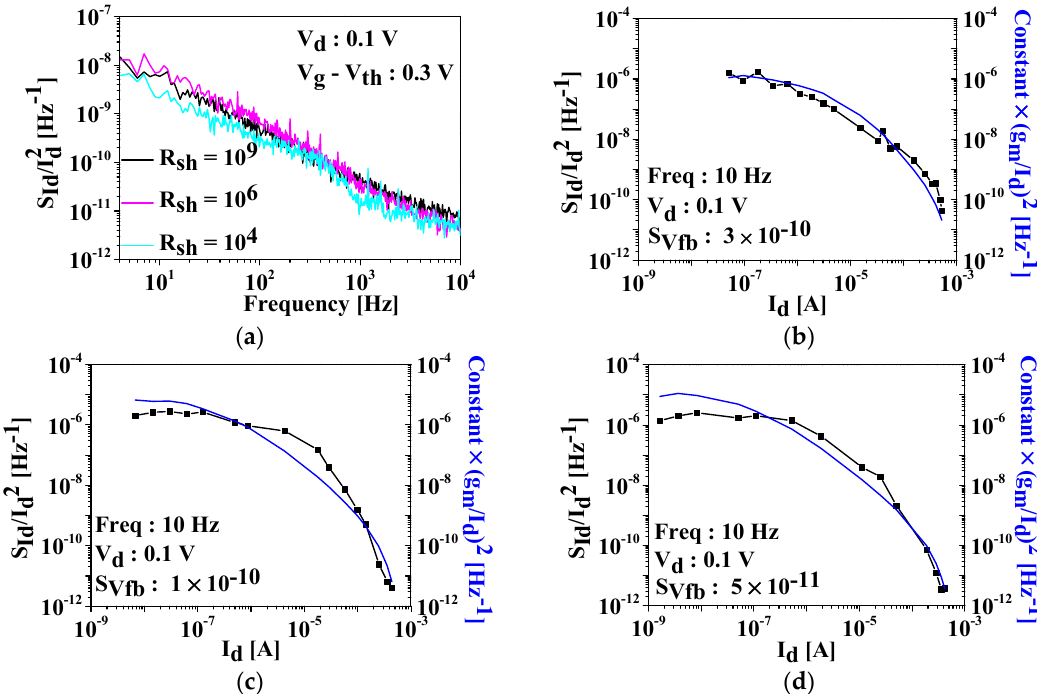
Figure 3. ( a ) Normalized noise spectral density ( S Id / I d 2 ) according to the frequency and S Id / I d 2 (black square) matching with (constant × ( g m / I d ) 2 ) (blue line) versus I d at V d = 0.1 V and f = 10 Hz for the devices with R sh = ( b ) 10 9 , ( c ) 10 6 , and ( d ) 10 4 , respectively.